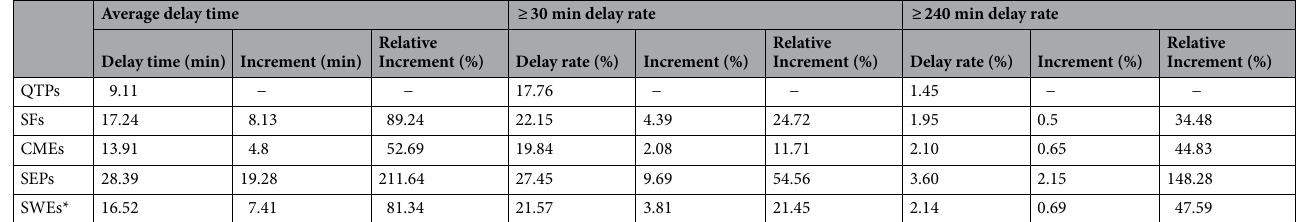
Table 1. Arrival delay time, ≥ 30-min delay rate and ≥ 240-min delay rate of flights during SFs, CMEs, SEPs, and all SWEs together with their (relative) increments relative to those during quiet time periods averaged over 5 airports. *The results of SWEs are calculated by weighted average of SFs, CMEs and